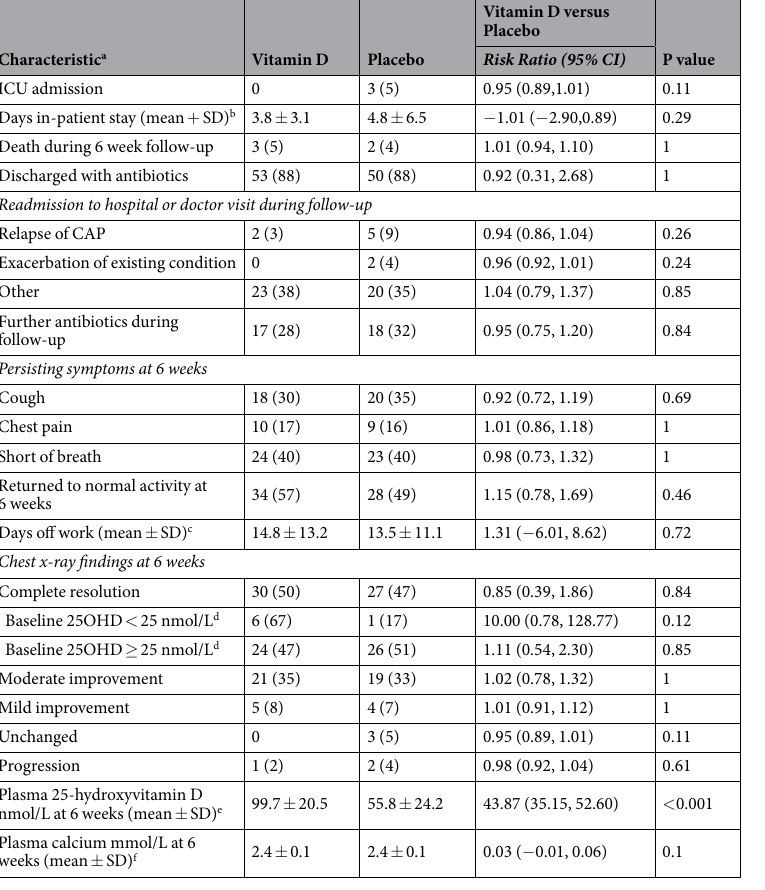
Table 2. Outcome measures by treatment group. a Unless otherwise stated values presented are the number of participants (%). No follow-up data was available for patients that died within the 6-week study period (vitamin D n = 3, placebo n = 2). b Includes days of stay for those who died in hospital (vitamin D n = 2; placebo n = 2). c Twenty five (42%) participants in the vitamin D treatment group and 23 (40%) participants in placebo treatment group were employed at the time of their admission to hospital for CAP. At 6 weeks follow-up 6 participants had not returned to work (vitamin D n = 3, placebo n = 3). d (%) is calculated on the total number of participants in each treatment arm that either had plasma 25OHD levels < 25 nmol/L or ≥ 25 nmol/L. e Data were not obtained for 13 participants (vitamin D n = 7; placebo n = 6) at 6 weeks post-treatment. f Plasma calcium values stated are corrected for plasma albumin concentrations. There was missing data for 14 participants (vitamin D n = 8; placebo n = 6) at 6 weeks